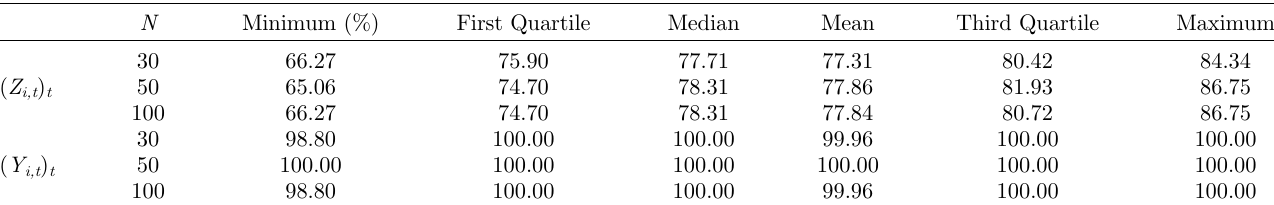
Table 15. Percentage of cases classi fi ed in the most indicated cluster. N : number of simulations with s = 15. Up: coding Z i,t – equation (4), Down: coding Y i,t – equation